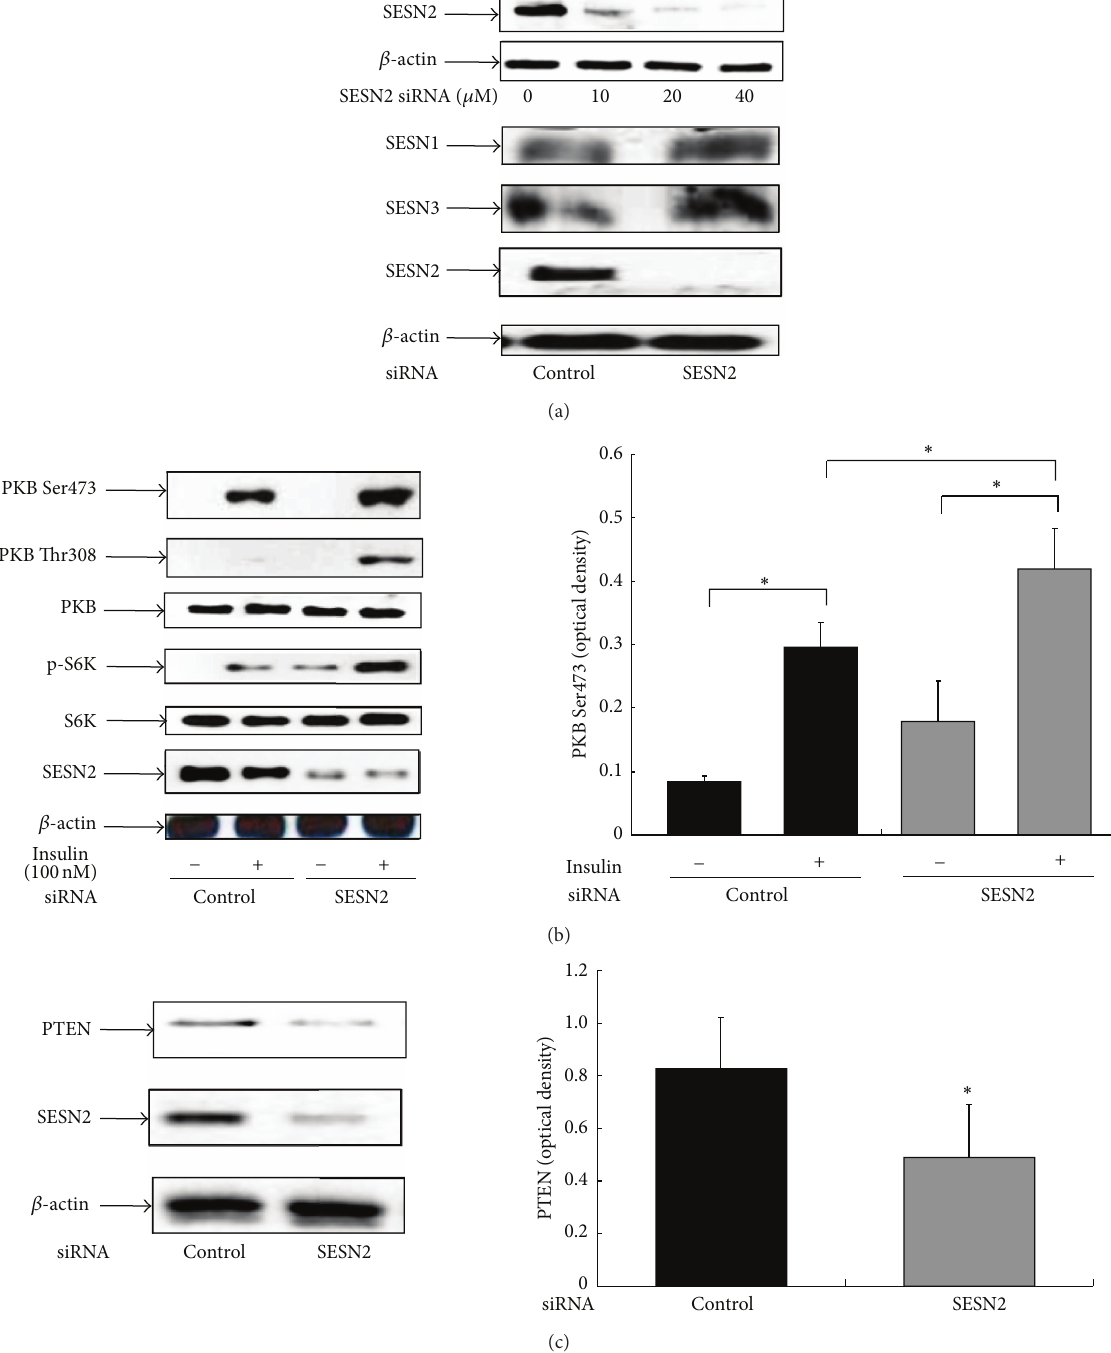
Figure 4: SESN2 siRNA knockdown enhances insulin signaling by repressing the PTEN level. HepG2 cells were transfected with either the control or the SESN2 siRNA for 48–72 h as indicated in Methods. (a) The cells were harvested for western blotting with indicated SESN antibodies. (b) and (c), HepG2 cells were transfected with either the control or the SESN2 siRNA for 48–72 h. The cells were then serum- starved for 4 h, followed by 100 nM insulin treatment for 15min. Western blotting was performed with indicated antibodies. Right panels show the results of densitometric analysis. ∗ 𝑃 < 0.05 compared with noninsulin